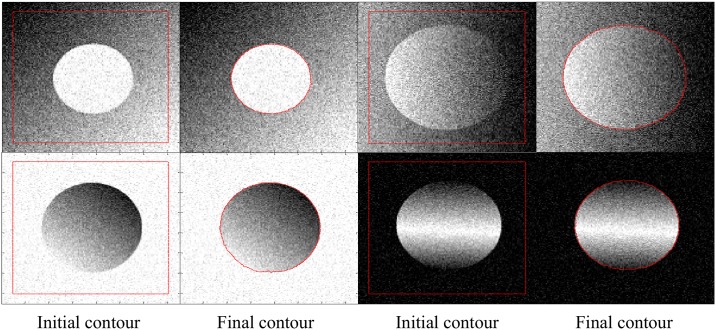
Segmentation results on different intensity inhomogeneous noisy images.